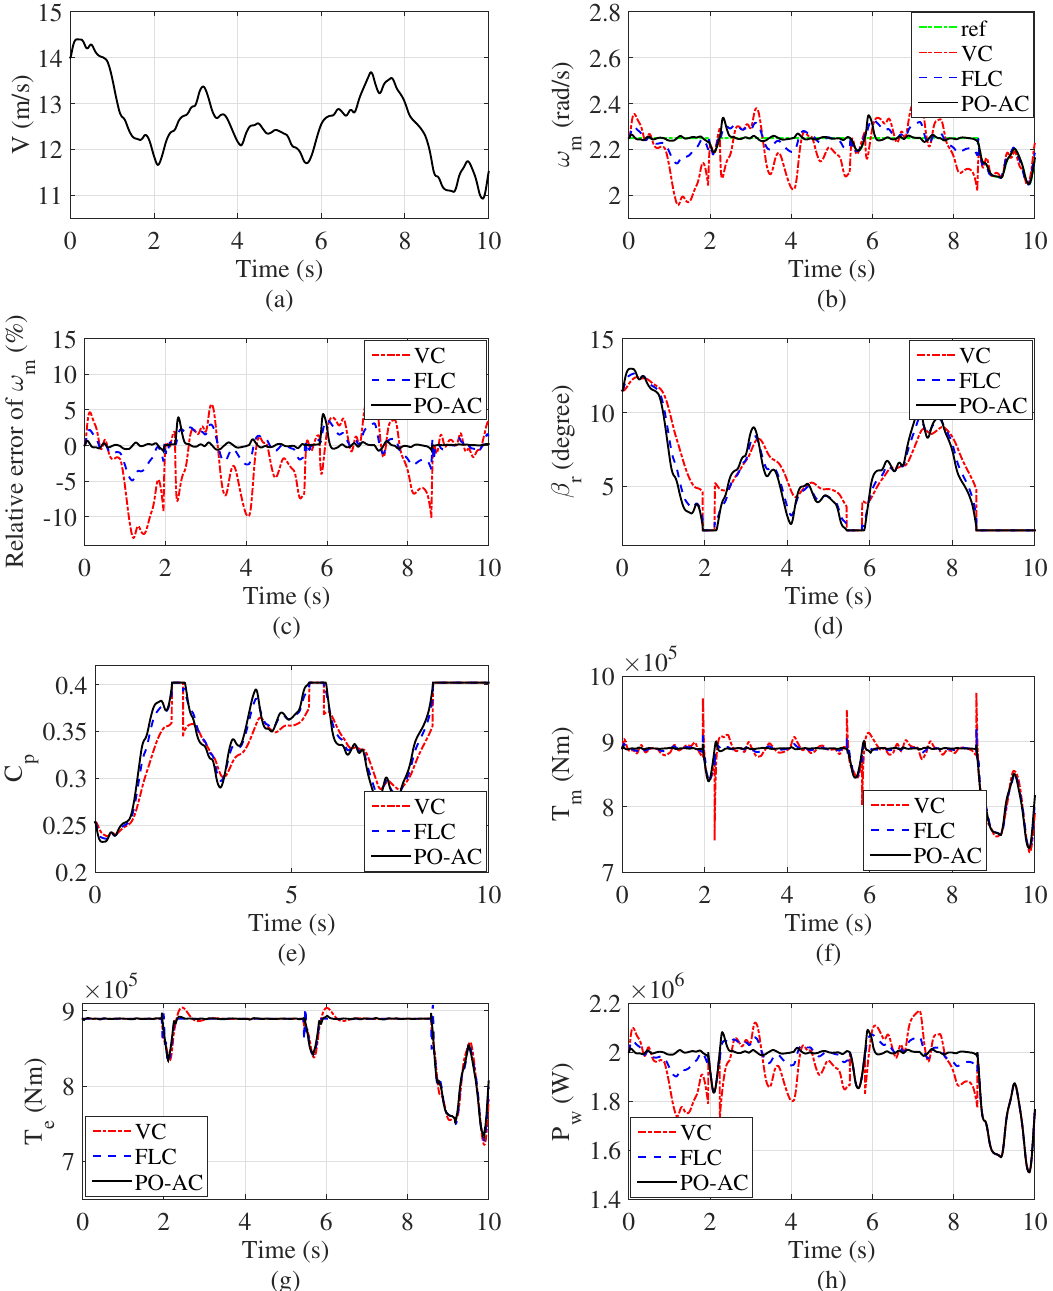
Figure 8. Responses of the WT to random wind speed. ( a ) Wind speed V. ( b ) Mechanical rotation speed ω m . ( c ) Relative error of mechanical rotation speed ω m . ( d ) Pitch angle reference β r . ( e ) Power coefficient C p . ( f ) Mechanical rotation torque T m . ( g ) Electromagnetic torque T e . ( h ) Mechanical power P w